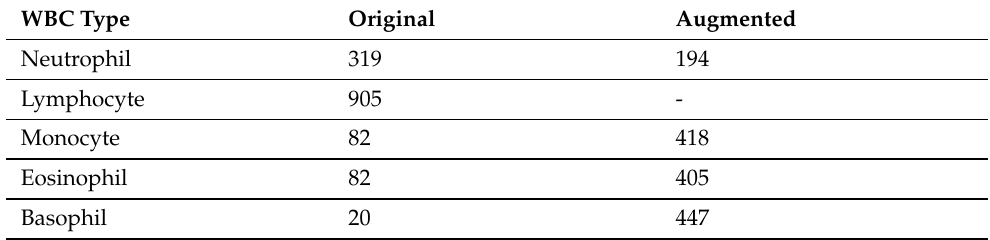
Table 2. Sample count in the original dataset.